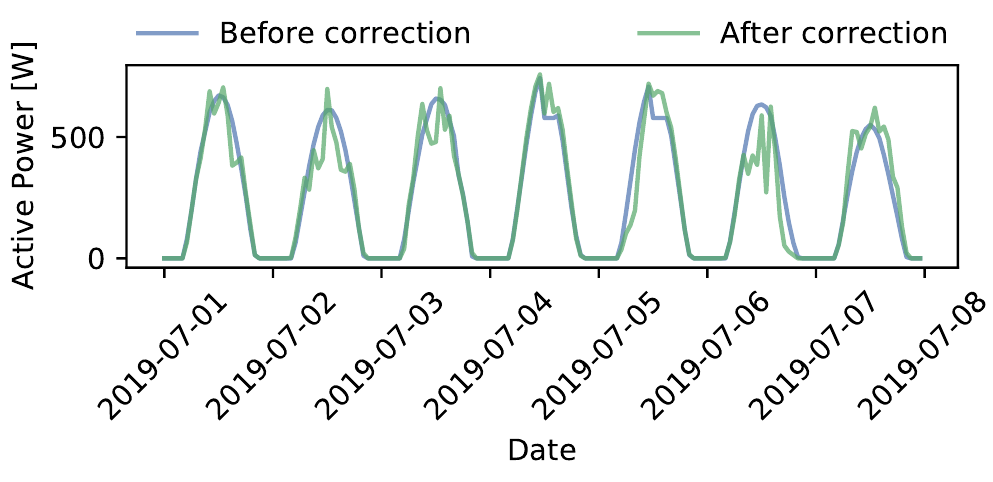
Figure 12. Curtailment profiles, before and after correction, for curtailment option 2.